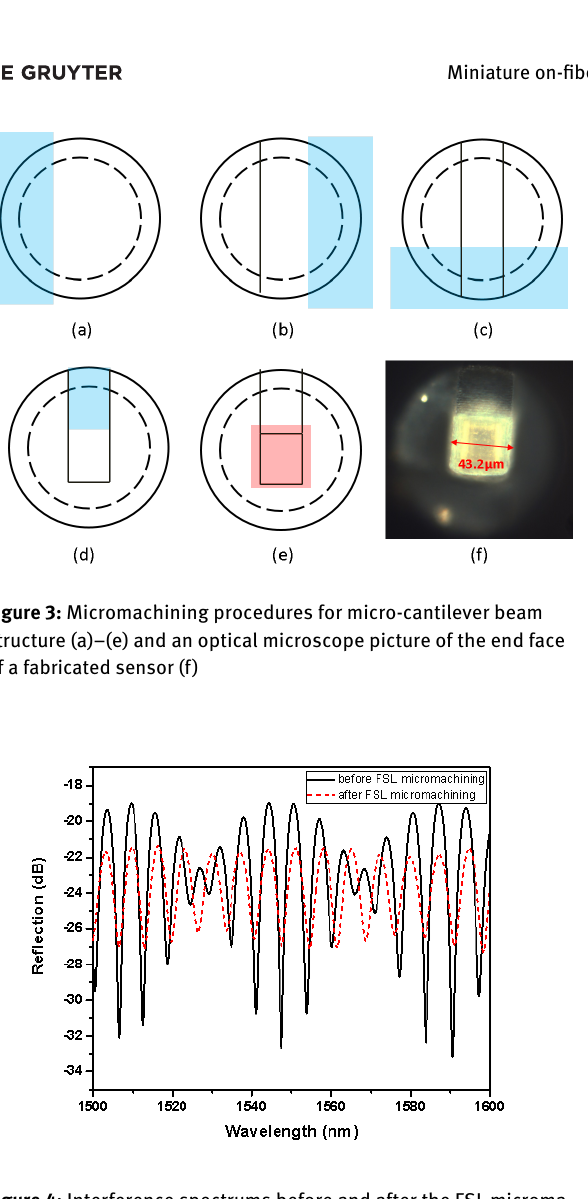
Figure 4: Interference spectrums before and after the FSL microma-